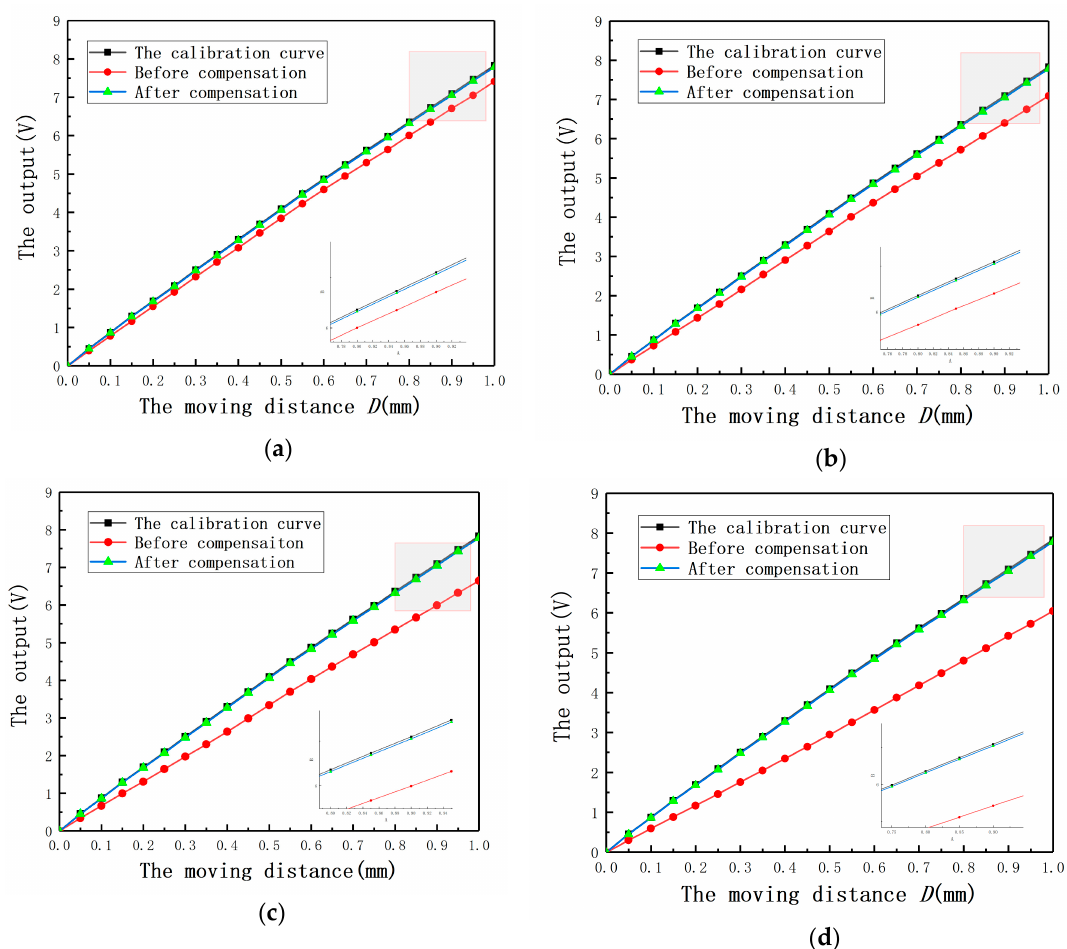
Figure 29. The output curves before and after compensation under di ff erent eccentricities: ( a ) E = 3 mm; ( b ) E = 4 mm; ( c ) E = 5 mm; ( d ) E = 6 mm.